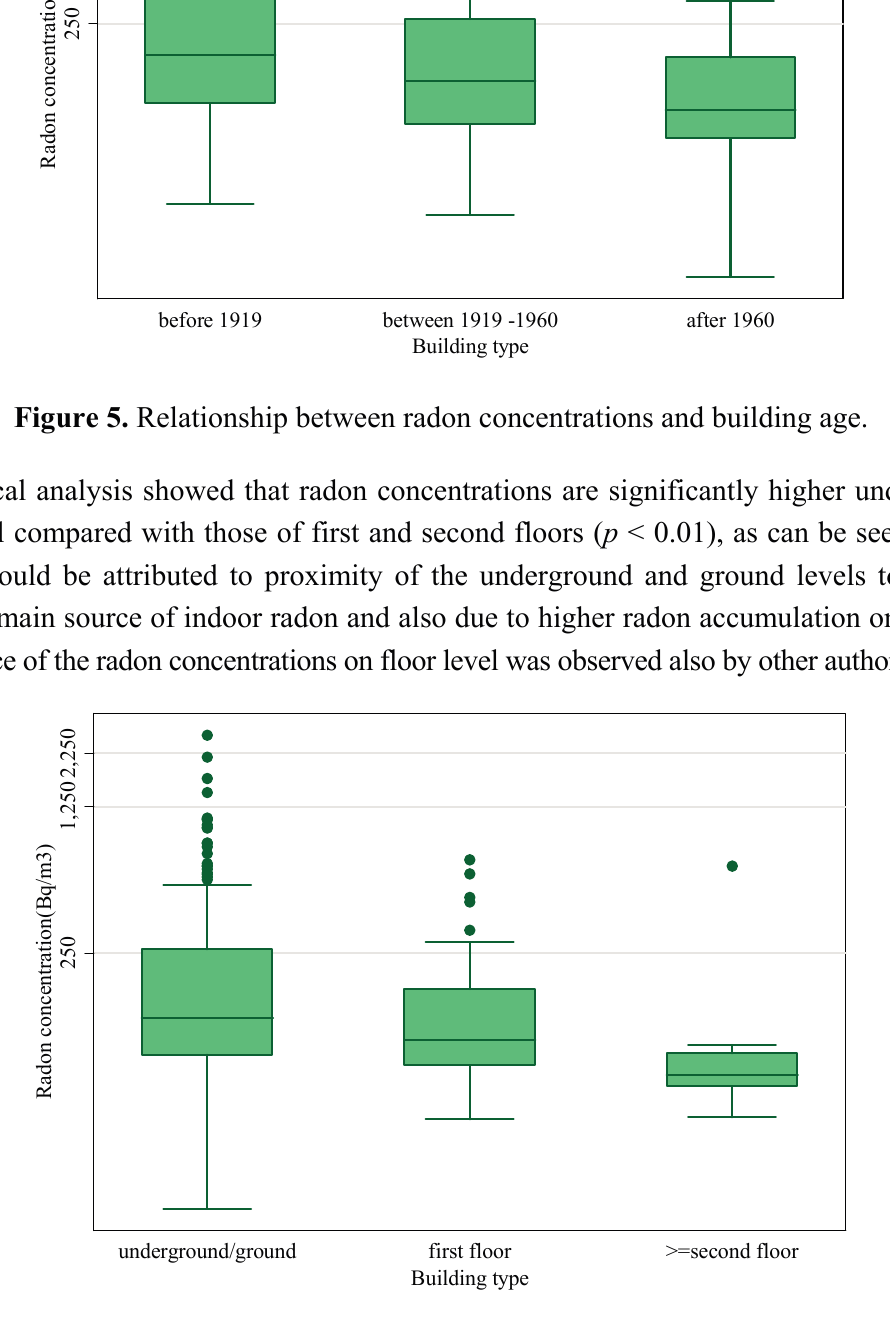
Figure 6. Relationship between radon concentrations and floor of the monitored